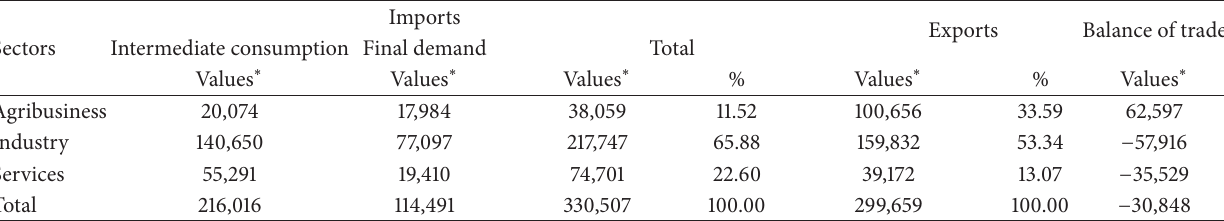
Table 7: Brazilian balance of trade,